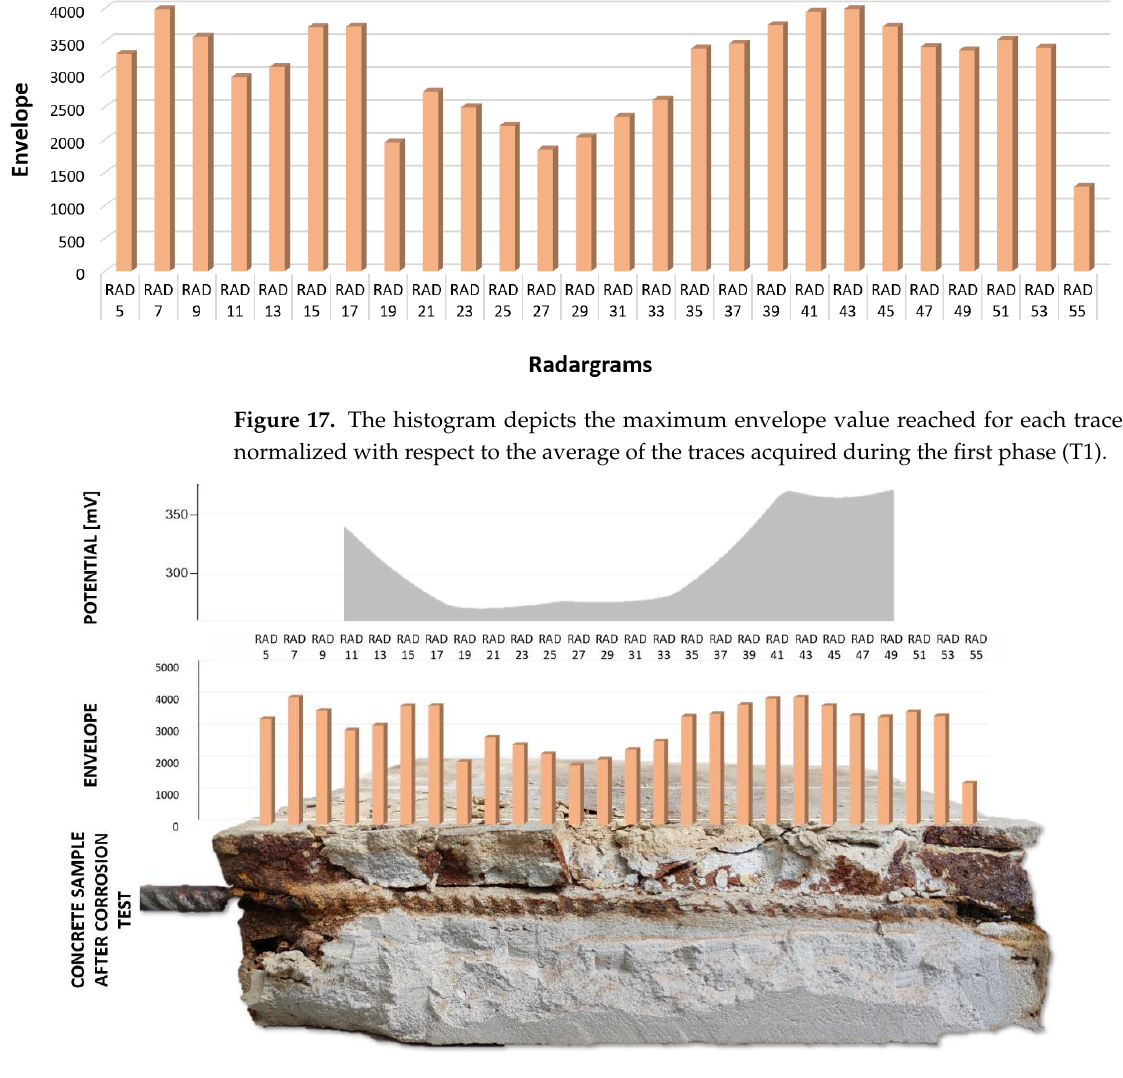
Figure 18. The picture of the broken sample in correspondence of the steel rebar with the histogram of the normalized envelope values and the self-potential profile along the sample.